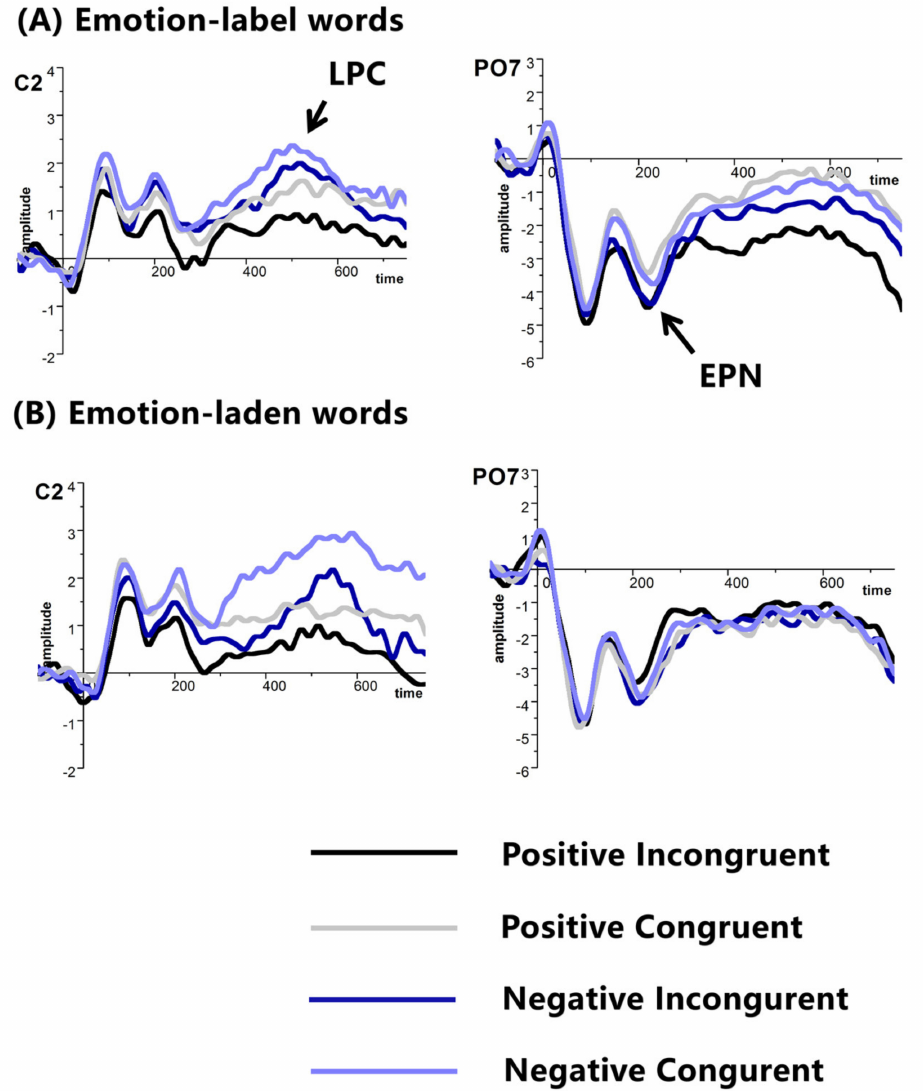
Figure 3. Grand average ERPs of EPN and LPC at selected electrodes with ( A ) emotion-label words, and ( B ) emotion-laden words as primes in Experiment 2, amplitude ( µ V), time